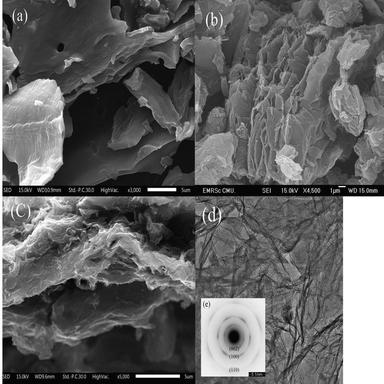
SEM images of the synthesized materials (a) G, (b) GPC (c) NGPC (d) TEM image of NGPC (e) SAED pattern of NGPC.